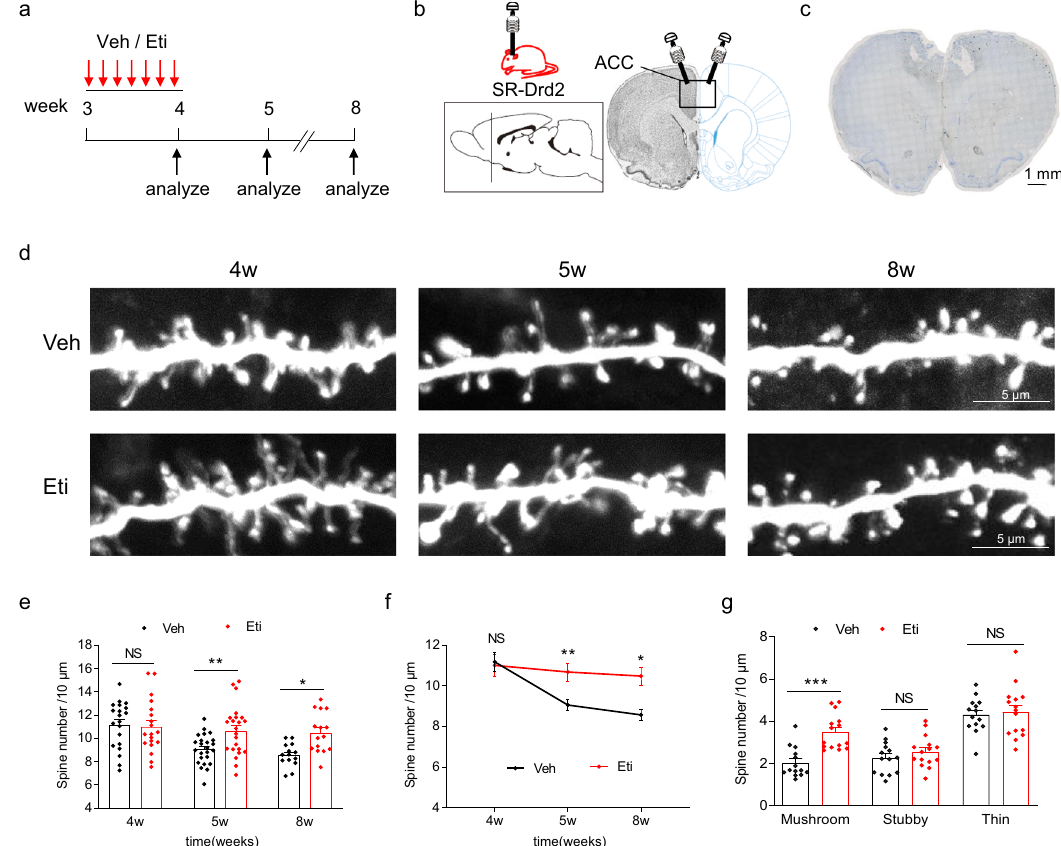
Fig. 7 Impaired synaptic pruning by DRD2 inhibition during adolescence. a Experimental design. SR-Drd2 rats received daily injection of Eti (1 μ g in 0.5 μ l per side) or Veh (0.5 μ l saline per side) into layer 5 of ACC between 3- and 4-week-old age, and the spine densities of secondary basal dendrites in Drd2- positive neurons were analyzed at different timepoints. b Diagram showing the injection of Veh or Eti into layer 5 of ACC in SR-Drd2 rat. The dashed line of the sagittal section diagram indicates the position of the coronal section. The rectangle indicates the brain regions of ACC. c Nissl staining to determine the injection sites. Scale bar, 1 mm. d Representative dendritic spines of Drd2-positive neurons at different aged SR-Drd2 rats, as in panel a . Scale bar, 5 μ m. e Impaired synaptic pruning in Drd2-postive neurons when inhibition of Drd2 between 3- and 4-week-old age. The spine densities of Drd2-positive neurons from different aged SR-Drd2 rats treated with Veh or Eti were quanti fi ed. NS not signi fi cant, P = 0.9879, two-way ANOVA followed by Sidak ’ s multiple comparisons test, n = 20 dendrites from 3 control rats, n = 19 dendrites from 3 Eti-treated rats. Data are presented as mean values± SEM. ** P = 0.0091, two-way ANOVA followed by Sidak ’ s multiple comparisons test, n = 24 dendrites from 4 control rats, n = 23 dendrites from 4 Eti-treated rats. Data are presented as mean values ± SEM. * P = 0.0181, two-way ANOVA followed by Sidak ’ s multiple comparisons test, n = 14 dendrites from 3 control rats, n = 15 dendrites from 3 Eti-treated rats. Data are presented as mean values ± SEM. f Line chart of the data in panel e . The statistical results are same as panel e . g Increased densities of mushroom-like spines in Drd2-positive neurons after inhibition of DRD2 between 3- and 4-week-old age. The densities of different types of dendritic spines in Drd2-positive neurons from 8-week-old rats were quanti fi ed. *** P < 0.0001, NS not signi fi cant, P (stubby) = 0.7185, P (thin) = 0.9601, two-way-ANOVA followed by Sidak ’ s multiple comparisons test, n = 14 dendrites from 3 control rats, n = 15 dendrites from 3 Eti-treated SR-Drd2 rats. Data are presented as mean values ± facilitating the tracking of shRNA production in individual cells. The target sequence of Drd2 shRNA against rat Drd2 is as follows ACTCAGATGCTTGCCA TTGTT. The control shRNA contains a nontargeting sequence as follows AAATGTACTGCGCGTGGAGAC. The titer of this AAV is 10 13 / μ l and we injected 0.5 μ l AAV into each side of ACC. Three-week-old male Drd2-Cre rats were anesthetized by intraperitoneal injection of pentobarbital sodium (40 mg/kg) and head- fi xed in a stereotaxic device (RWD life science). The AAV was delivered through stereotaxic injector (Stoelting) with a speed of 0.1 μ l / min. The injection coordinates are as follows: anteroposterior (AP) + 1.40mm, dorsoventral (DV) − 1.95mm, mediolateral (ML)± 0.47 mm relative to Bregma.